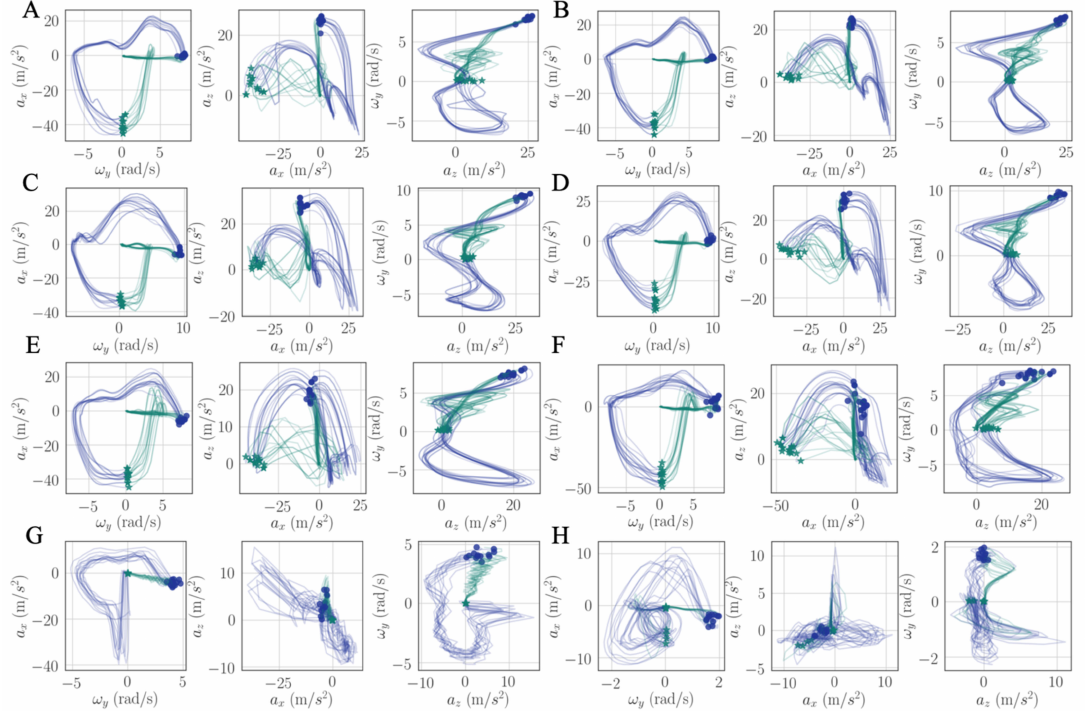
(cid:8) (cid:9) (cid:8) (cid:9) a x ( t ) , ω y ( t ) a z ( t ) , ω y ( t ) , { a x ( t ) , a z ( t ) } , , gait cycle trajectories